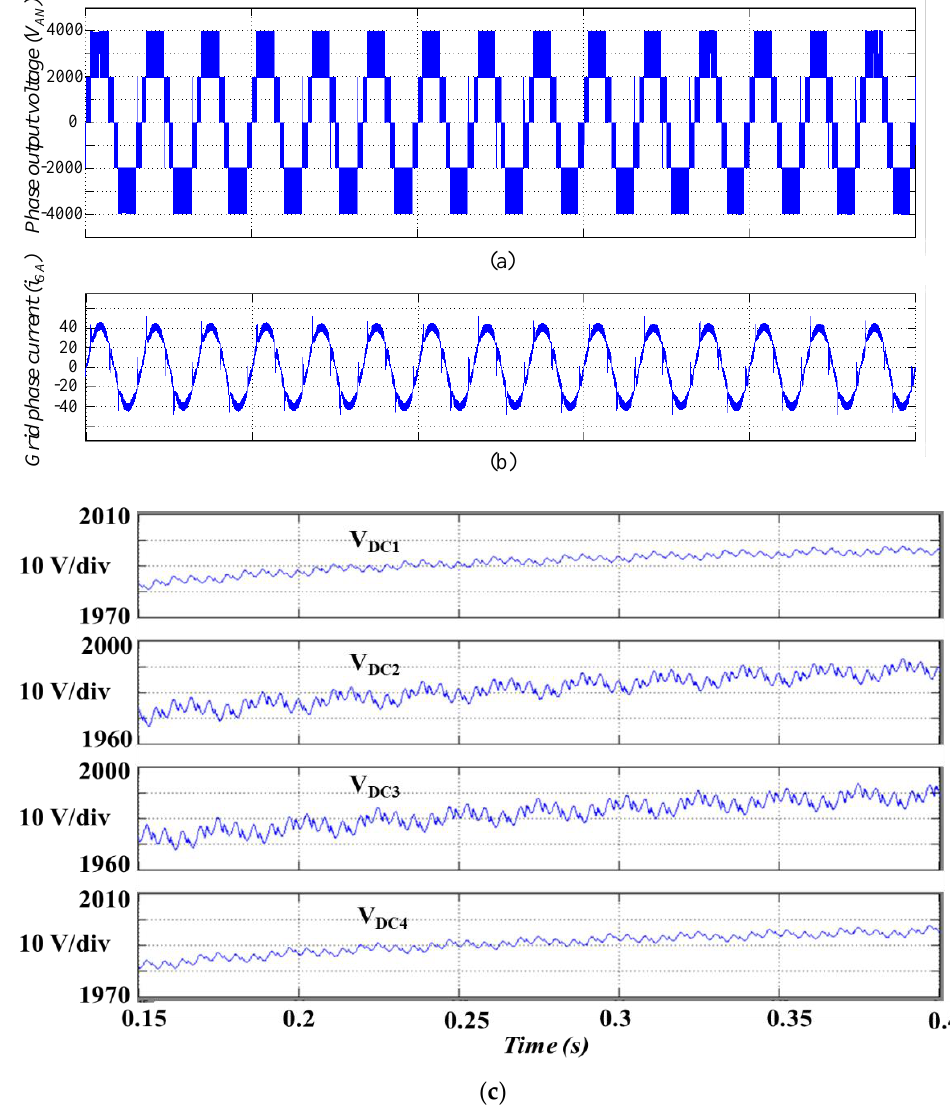
Figure 11. Simulation waveforms of the proposed five-level STATCOM with a three-phase diode rectifier load. ( a ) Phase output voltage ( V AN ) for Phase A; ( b ) Grid phase current ( i GA ) for Phase A; ( c ) DC-link capacitor voltages ( V DC 1 - V DC 4 ).